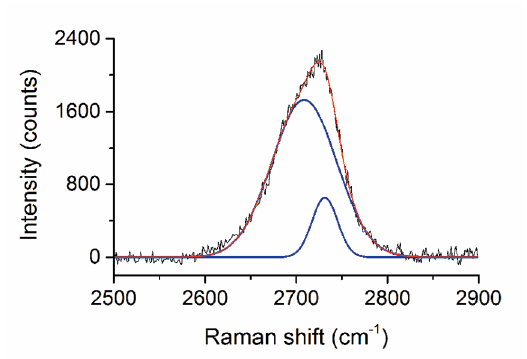
Figure 8. 2D band from a graphite nodule of a sample of base alloy + 3 % SiC fitted by two Lorentzian peaks. wt